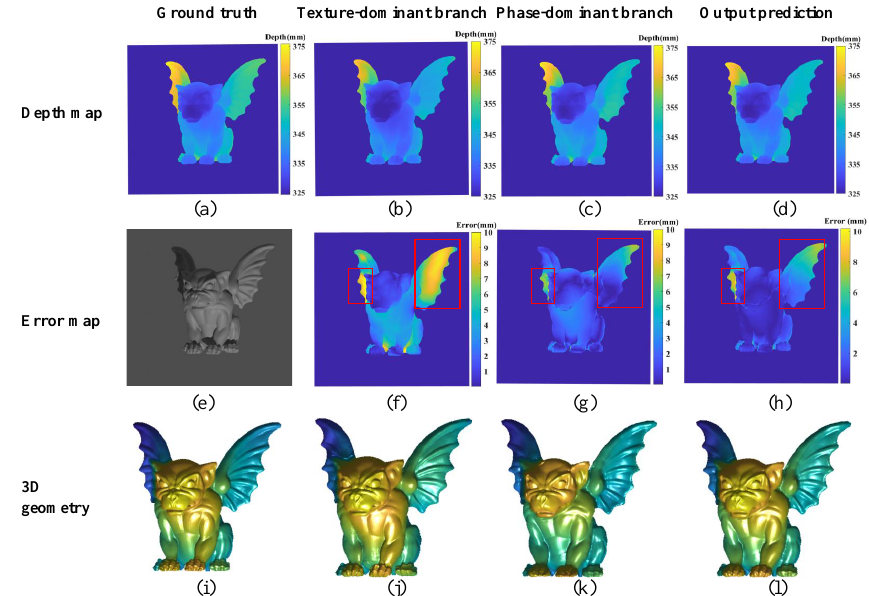
Figure 8. Comparing functions of the texture-dominant branch and phase-dominant